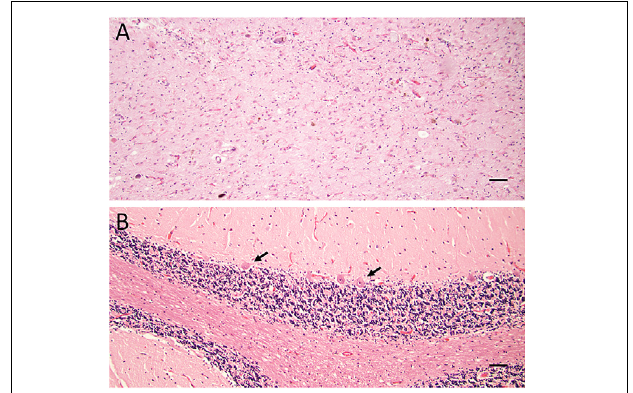
FIGURE 1 | (A,B) Haematoxylin-eosin staining showing severe loss of neuromelanin-containing neurons in substantia nigra and marked astrogliosis (A) . Reduction in the number of Purkinje cells (arrows) in cerebellum (B) . Scale bars: 100 µ